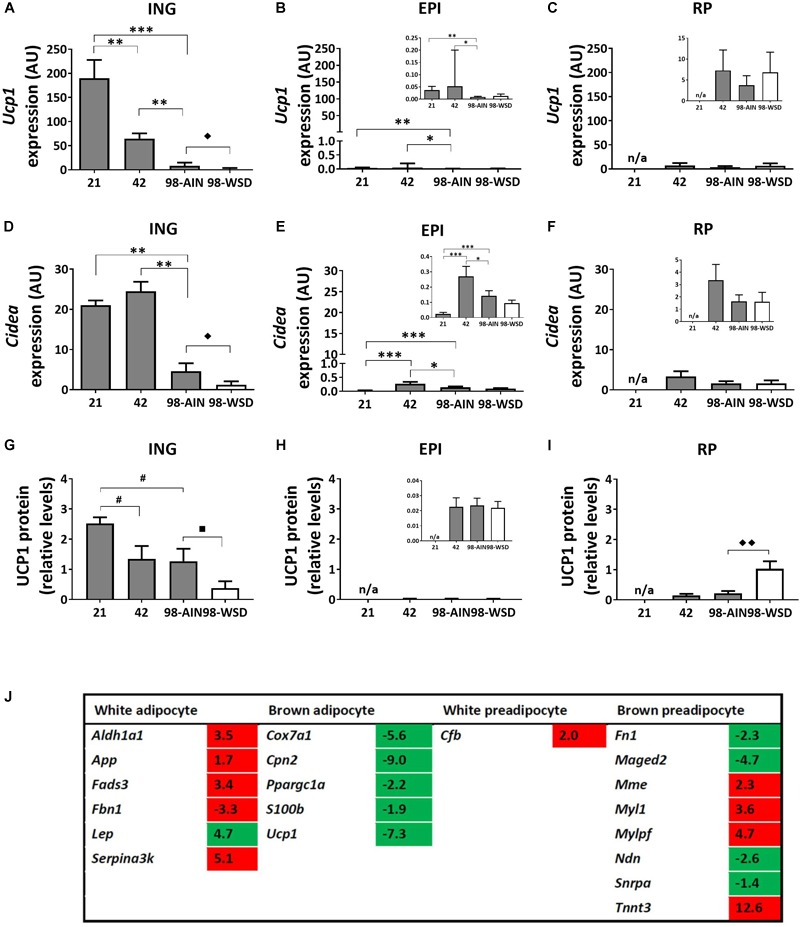
Changes in gene expression of browning markers between PN21 and PN98. Ucp1 gene expression in (A) ING WAT, (B) EPI WAT, (C) RP WAT; Cidea expression in (D) ING WAT, (E) EPI WAT, (F) RP WAT; UCP1 protein levels in (G) ING WAT, (H) EPI WAT, (I) RP WAT; and (J) Regulation of genes selective for brown or white (pre)adipocytes over time, analyzed with mRNA sequencing, gene list derived from Gesta et al. (2007) and expression levels of transcripts with p < 0.05 included in table. Inserts in figures B, C, E, F, and H show the same data with adapted y-axis for better visualization of the low expression data. PN, postnatal day; AIN, AIM93-G diet; WSD, western style diet. Gene expression data expressed as mean + SEM and protein levels as mean levels corrected for total protein (Coomassie staining) + SEM, n = 8 for PN 21 and PN42, n = 11 for PN98, no data available (n/a) for RP WAT at PN21. Time and WSD effects were analyzed separately; time effect: ∗p < 0.05; ∗∗p < 0.01; ∗∗∗p < 0.001; #0.05 < p < 0.1; WSD effect: ◆p < 0.05; ◆◆
p < 0.01; ■0.05 < p < 0.1. Sequence data reported as fold changes between postnatal day 21 over 98. Up regulated values red and down regulated values green.